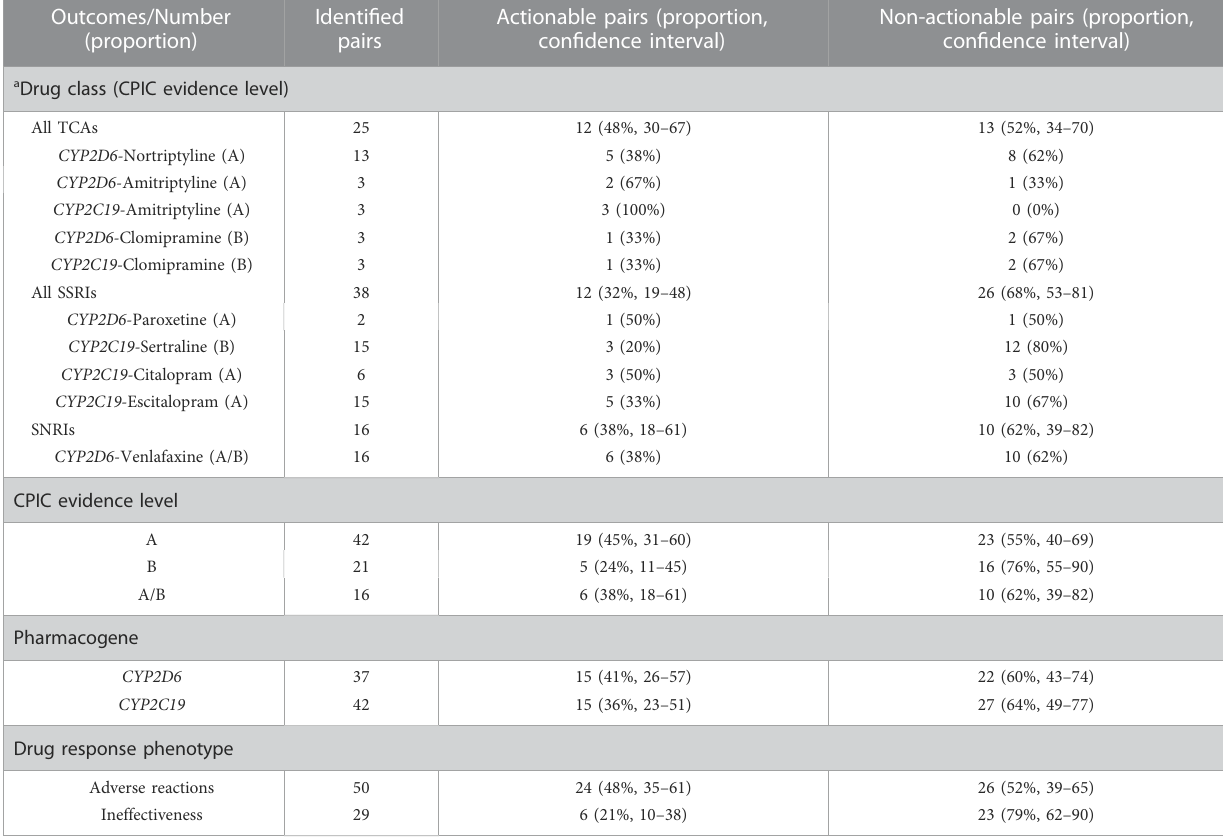
TABLE 4 The proportion of actionable and non-actionable gene-antidepressant-response pairs. Outcomes/Number